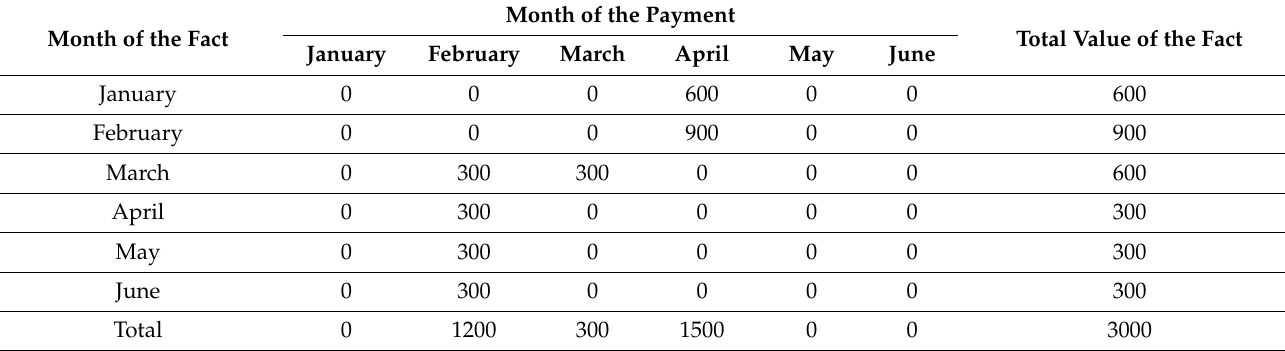
Table 5. Matrix of facts and payments, USD